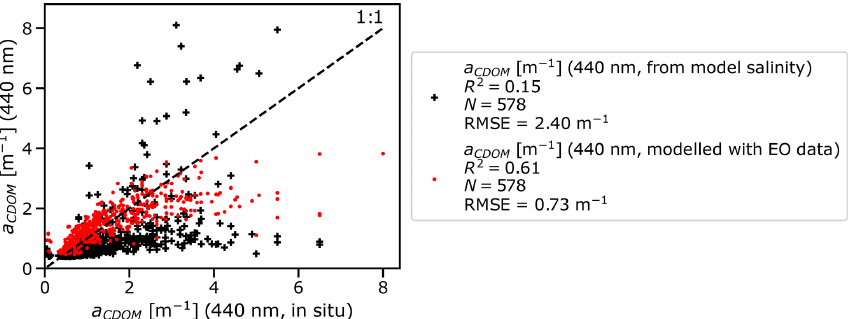
Figure 5. In situ a CDOM ( x axis) vs. ERGOM a CDOM ( y axis) estimated from salinity (in black) and ERGOM a CDOM with the EO method (in red).